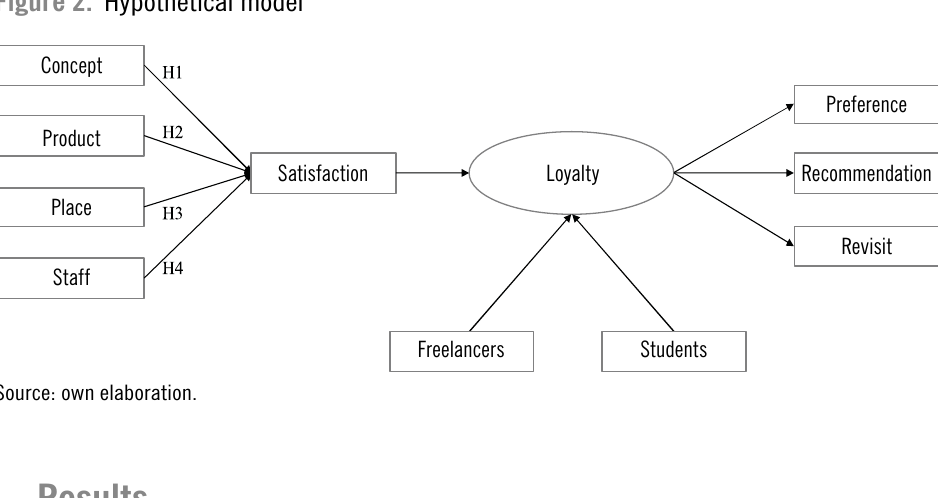
Figure 2. Hypothetical